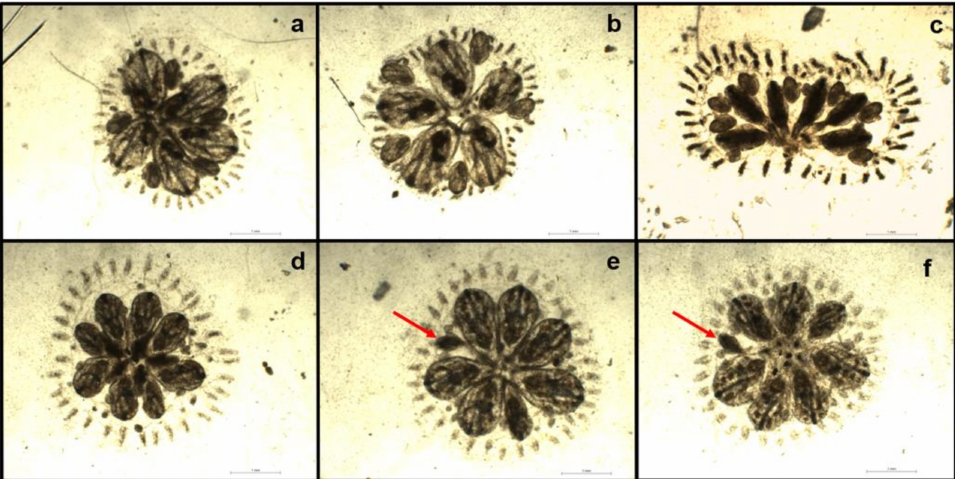
Figure 6. Colonies of B. schlosseri treated with PAHs to show a range of possible morphological reactions and their classification according to health scores. ( a ) Control at t 24 ; ( b ) concentration 19.2 × 10 5 µ g/L at t 24 , showing a score 1 colony; ( c ) concentration 19.2 × 10 5 µ g/L at t 48 , showing a score 3 colony; ( d ) concentration 19.2 × 10 4 µ g/L at t 24 ; ( e ) concentration 19.2 × 10 4 µ g/L at t 48 showing most zooids in the good state (score 1) and one malformed zooid (red arrow); ( f ) same colony as in (e) observed by the opposite site of the acetate. Both ( e ) and ( f ) show a zooid in a phase of re-absorption (red